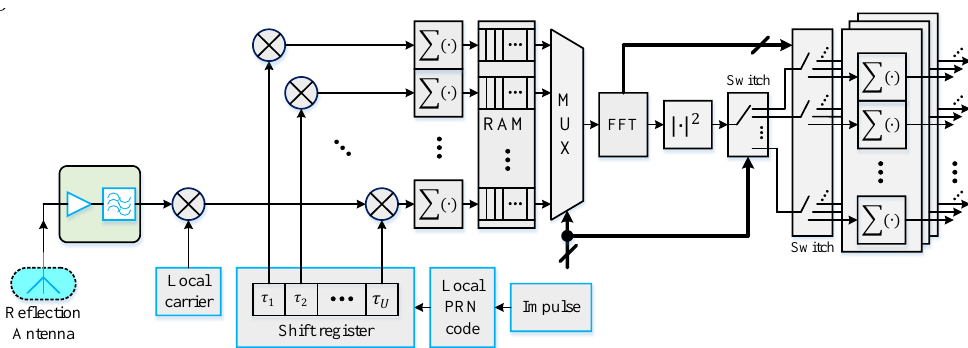
Figure 4. Signal processing structure of a DDM generation sub-channel of the GNSS-R module in the